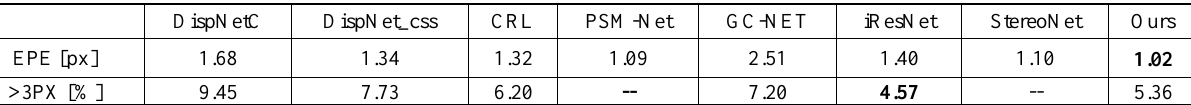
Table 2 Comparison results of different stereo matching methods on the Scene Flow dataset.